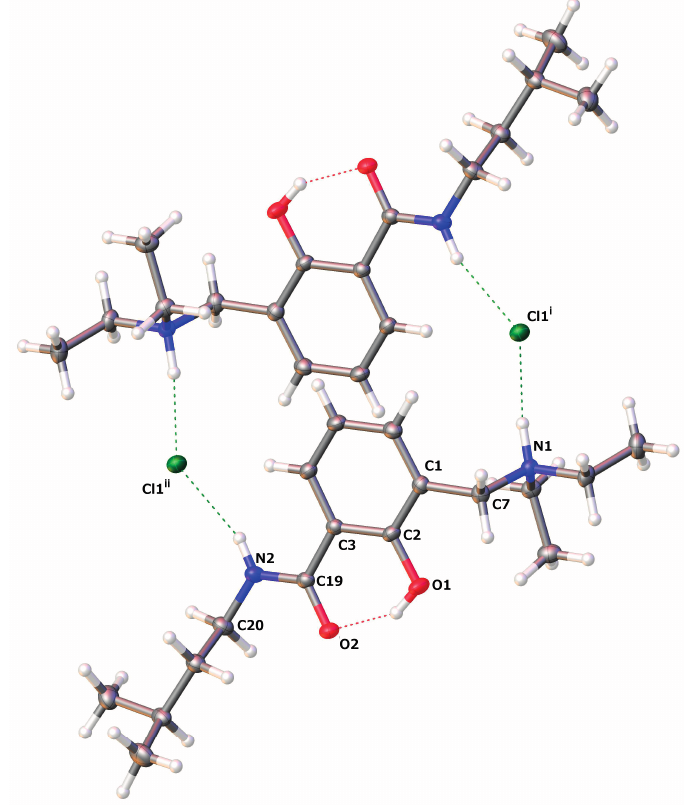
Figure 12. Crystal packing pattern showing intermolecular H-bonding to chloride ions in dimers of 14 (dashed lines: hydrogen